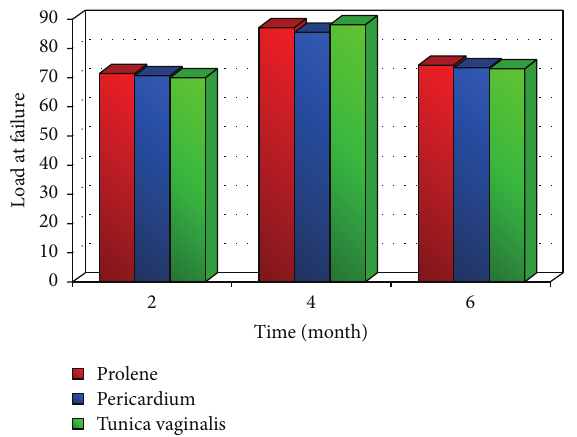
Figure 3: Load at failure for prolene, pericardium, and tunica vaginalis at different times